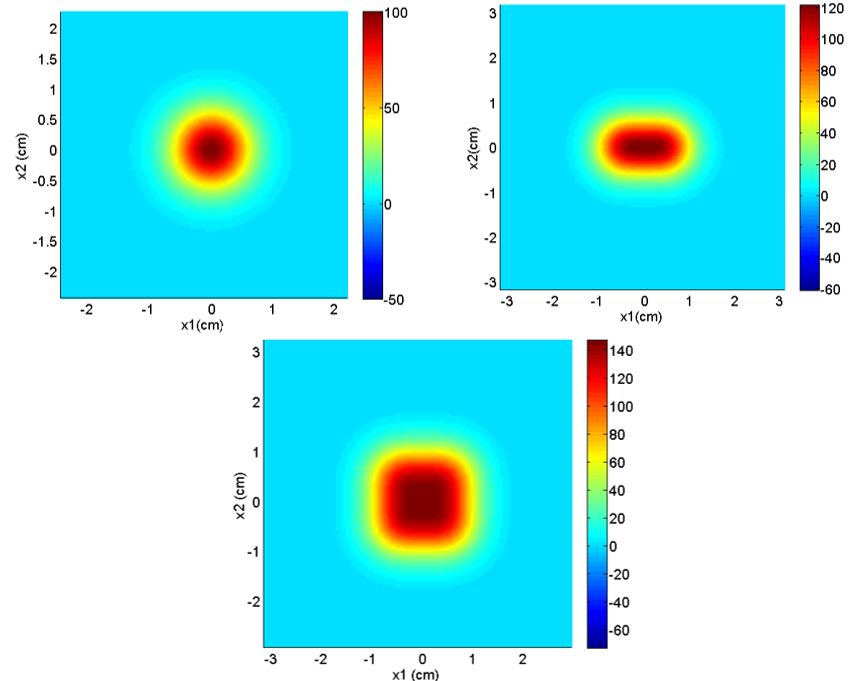
Figure 1. Two-dimensional (2D) visualization at 1 cm distance from source related to a single LED, two LEDs and four LED matrix with optimal spacing of 6.4 mm. The color scales are normalised and in arbitrary